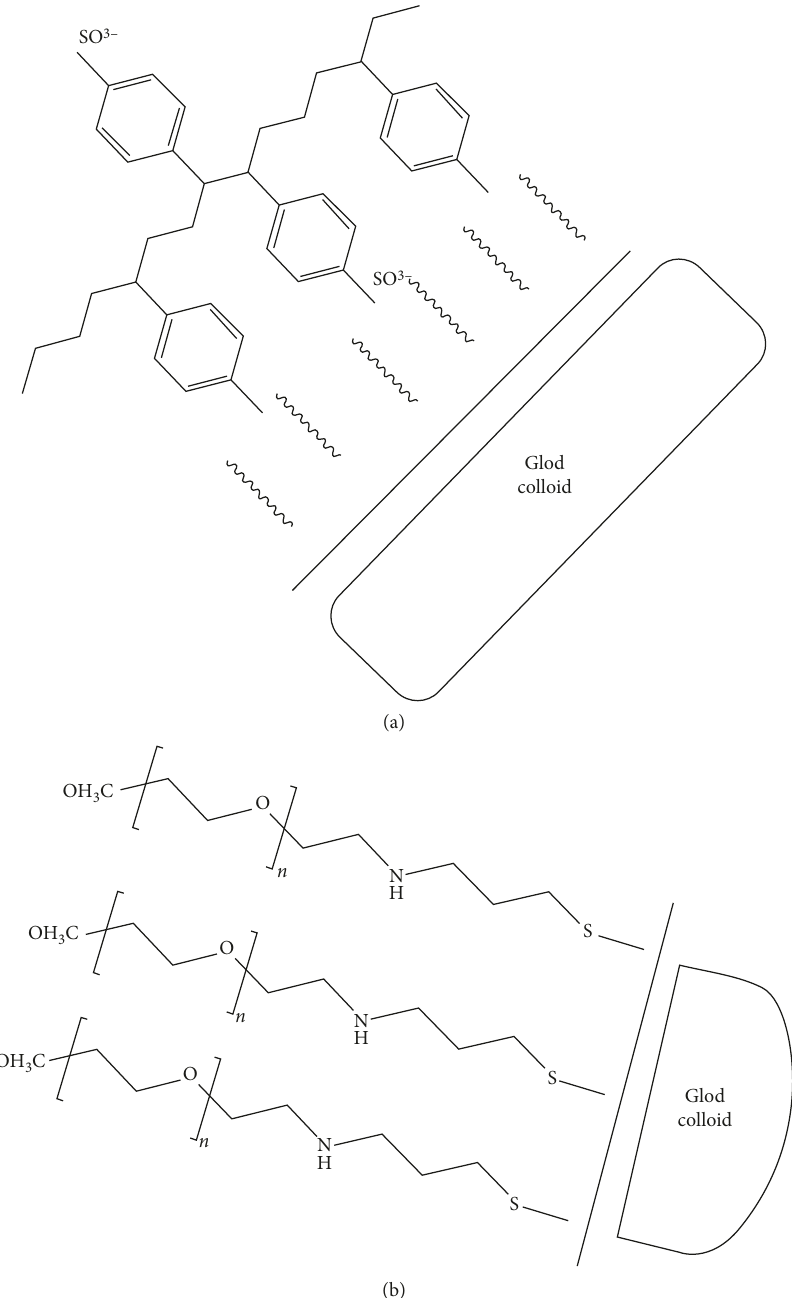
Figure 11: Surface modification of AuNRs. (a) PSS, encapsulation occurs on the CTAB bilayer through electrostatic adsorption. (b) mPEG- SH, replacement of the CTAB by PEG by the gold sulphur binding